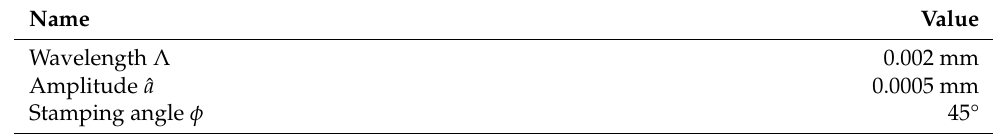
Table A2. Geometry assumptions wave